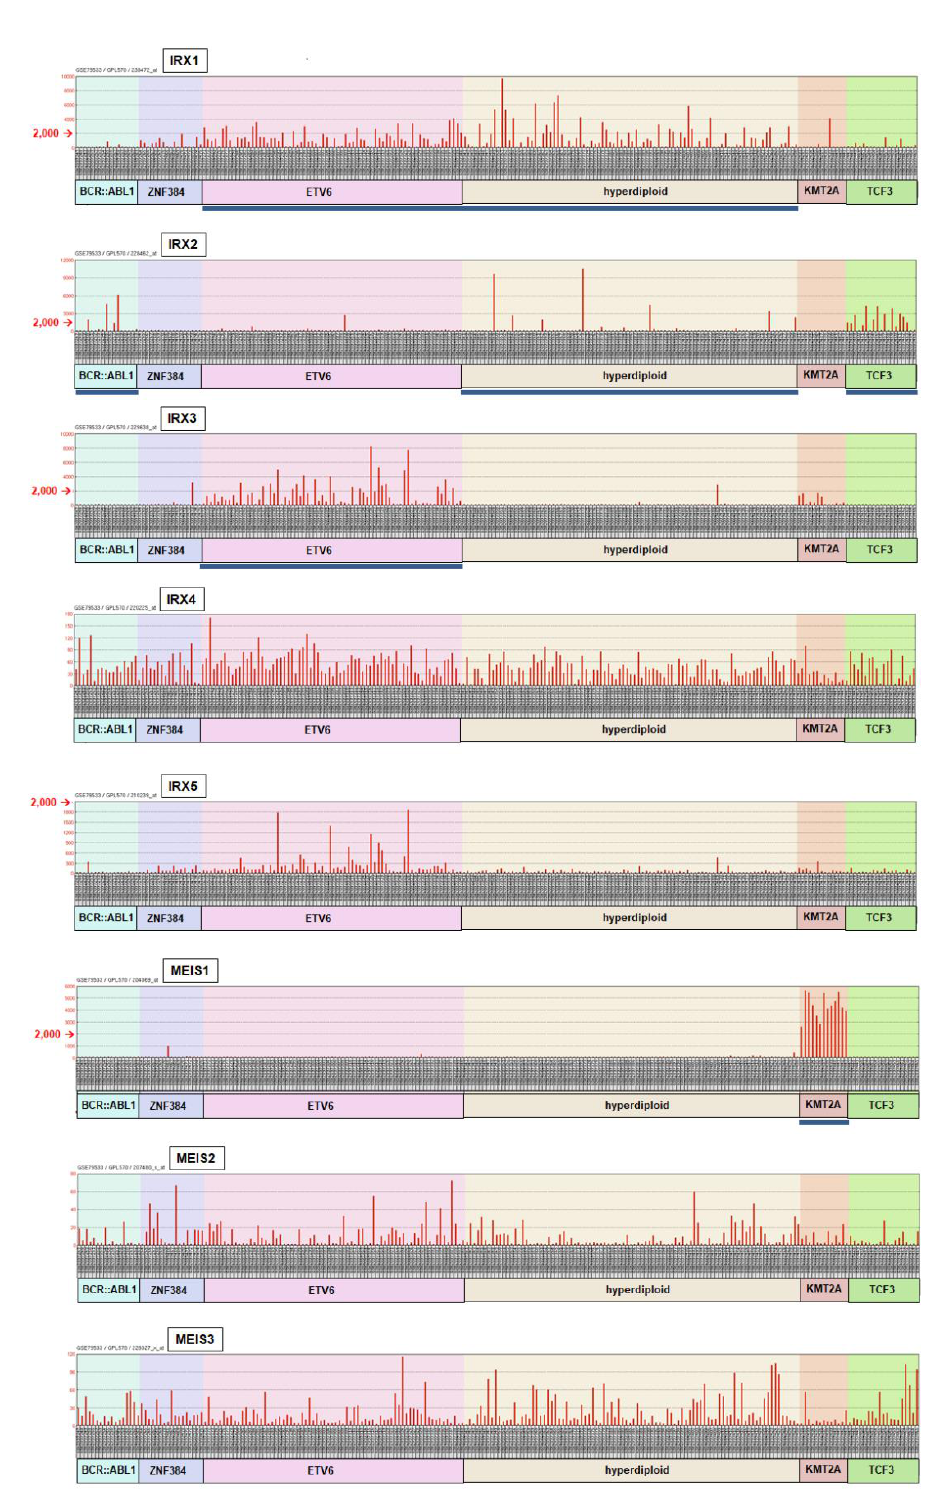
Figure 2. IRX and MEIS gene activities in BCP-ALL patients. Expression analyses of TALE homeobox genes IRX1, IRX2, IRX3, IRX4, IRX5, MEIS1, MEIS2 and MEIS3 in 226 pediatric BCP-ALL patients (dataset GSE79533). The patient samples are arranged according to the following indicated subtypes: BCR::ABL1, ZNF384, ETV6, hyperdiploid, KMT2A and TCF3. The expression level of 2,000 is highlighted. Subtypes containing at least two patients with significant expression levels (>2,000) are indicated by a bold blue line.